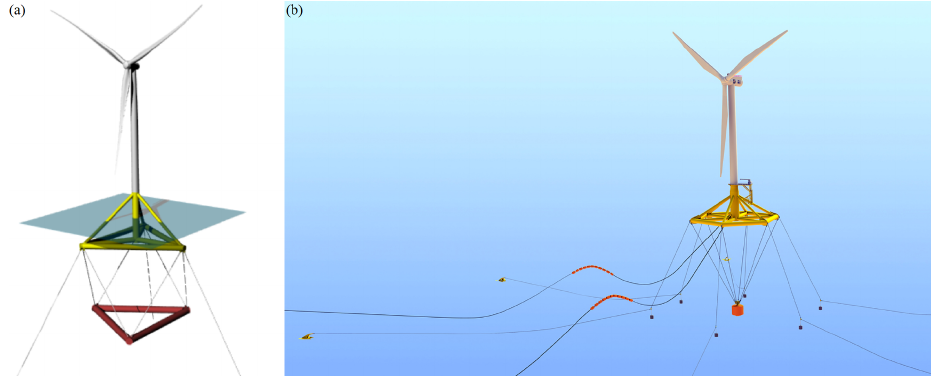
Figure 6. Pendulum-stabilized innovative floating platform concepts. (a) Stiesdal’s TetraSpar (Borg et al., 2020). (b) Saipem’s Hexafloat (Ribuot,